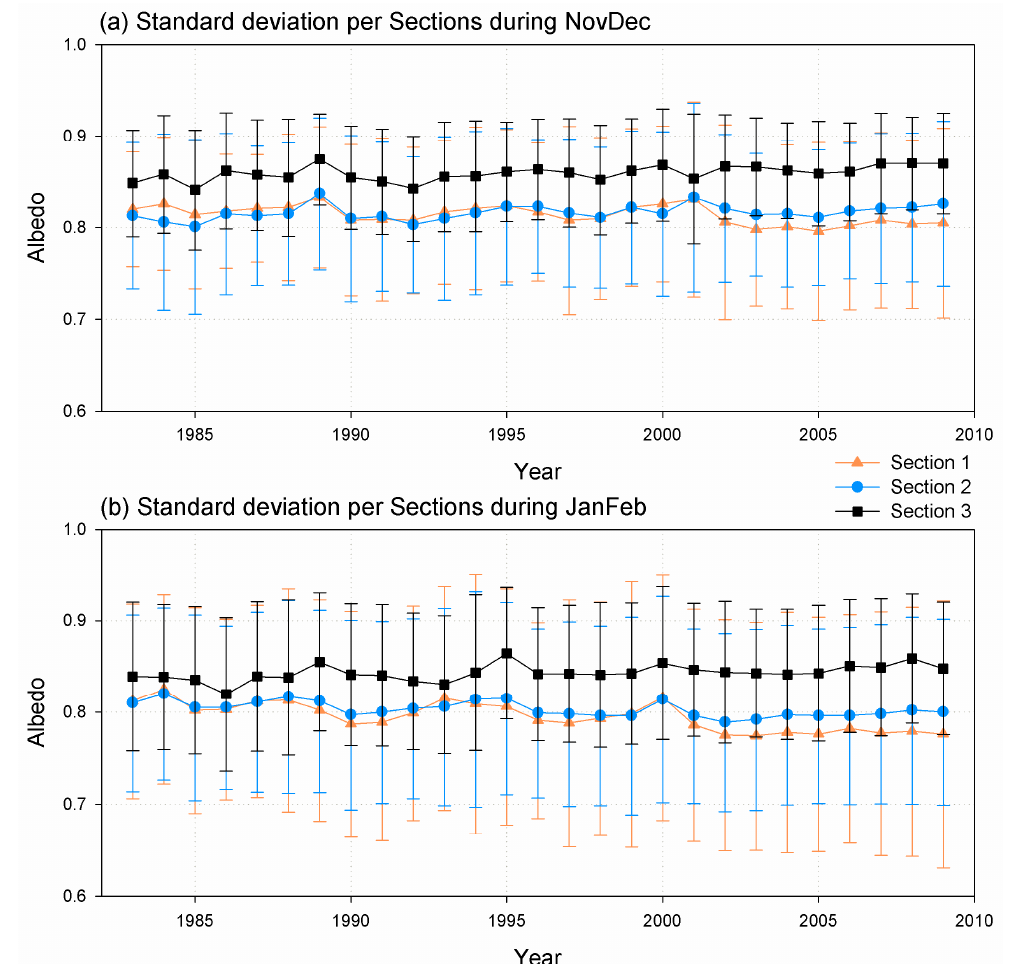
Figure 2. Distribution of standard deviation on albedo time series for each section (orange is Section 1, blue is Section 2, and black is Section 3), where vertical lines indicate the standard deviation in each section: ( a ) November–December; and ( b ) January–February.